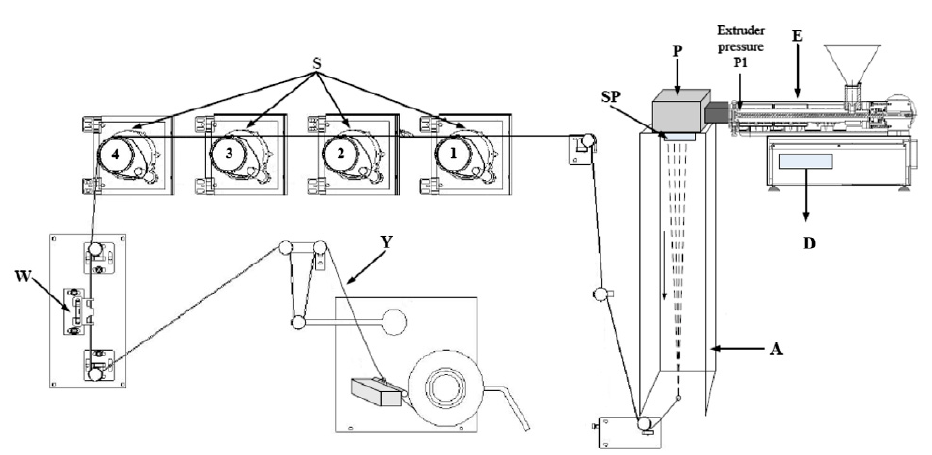
Figure 1. Principal scheme of the laboratory spinning equipment COLLIN ® CMF 100 (Dr. Collin